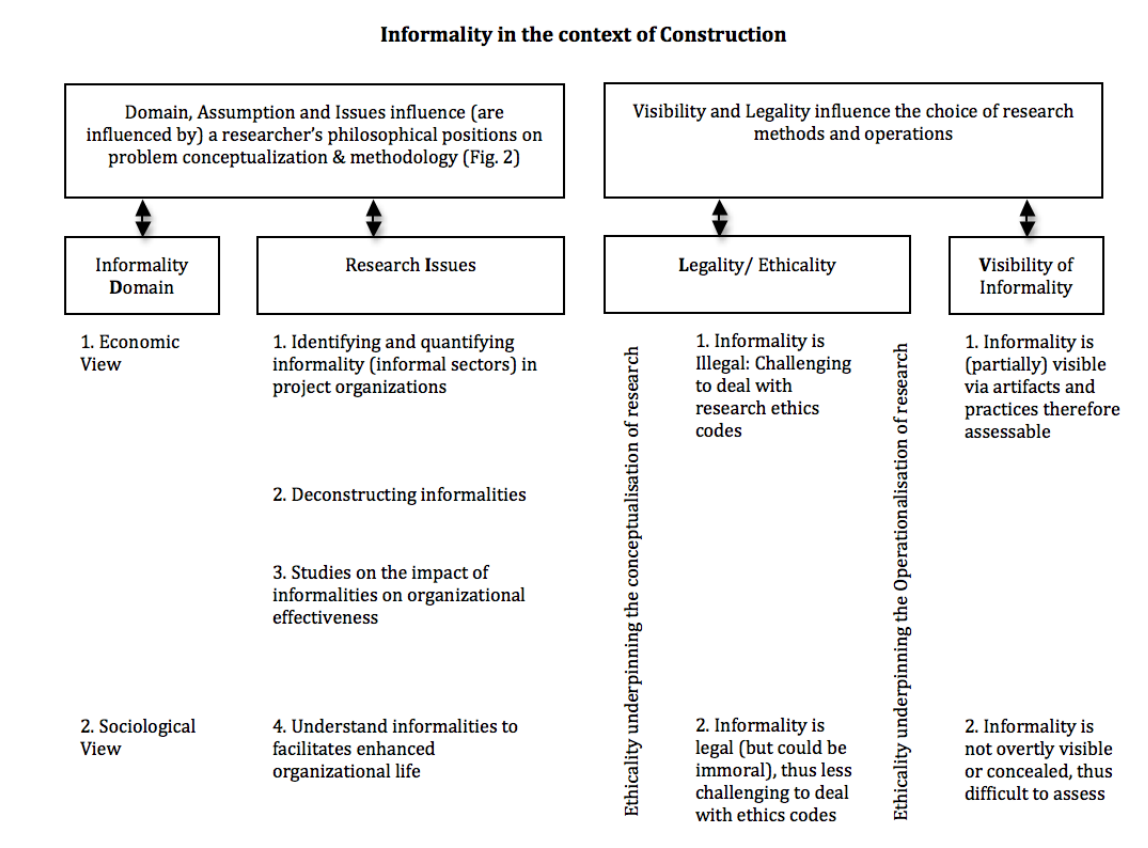
Figure 1 A framework for conceptualising informality in construction